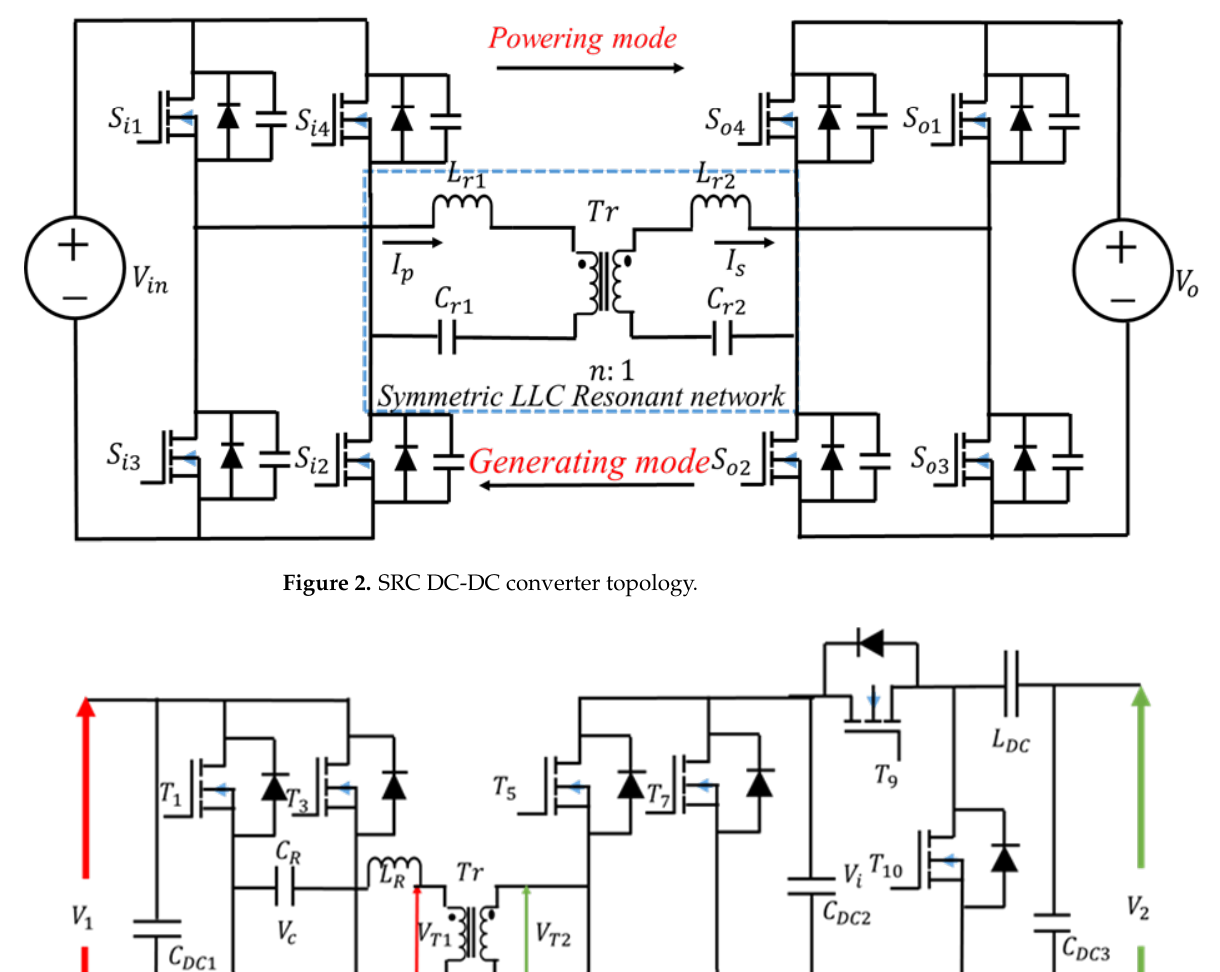
5 of 28 Figure 1. Three-phase on-board charger topology based on active rectifier and single DAB. 2.1. Development Trend of DC-DC Converter